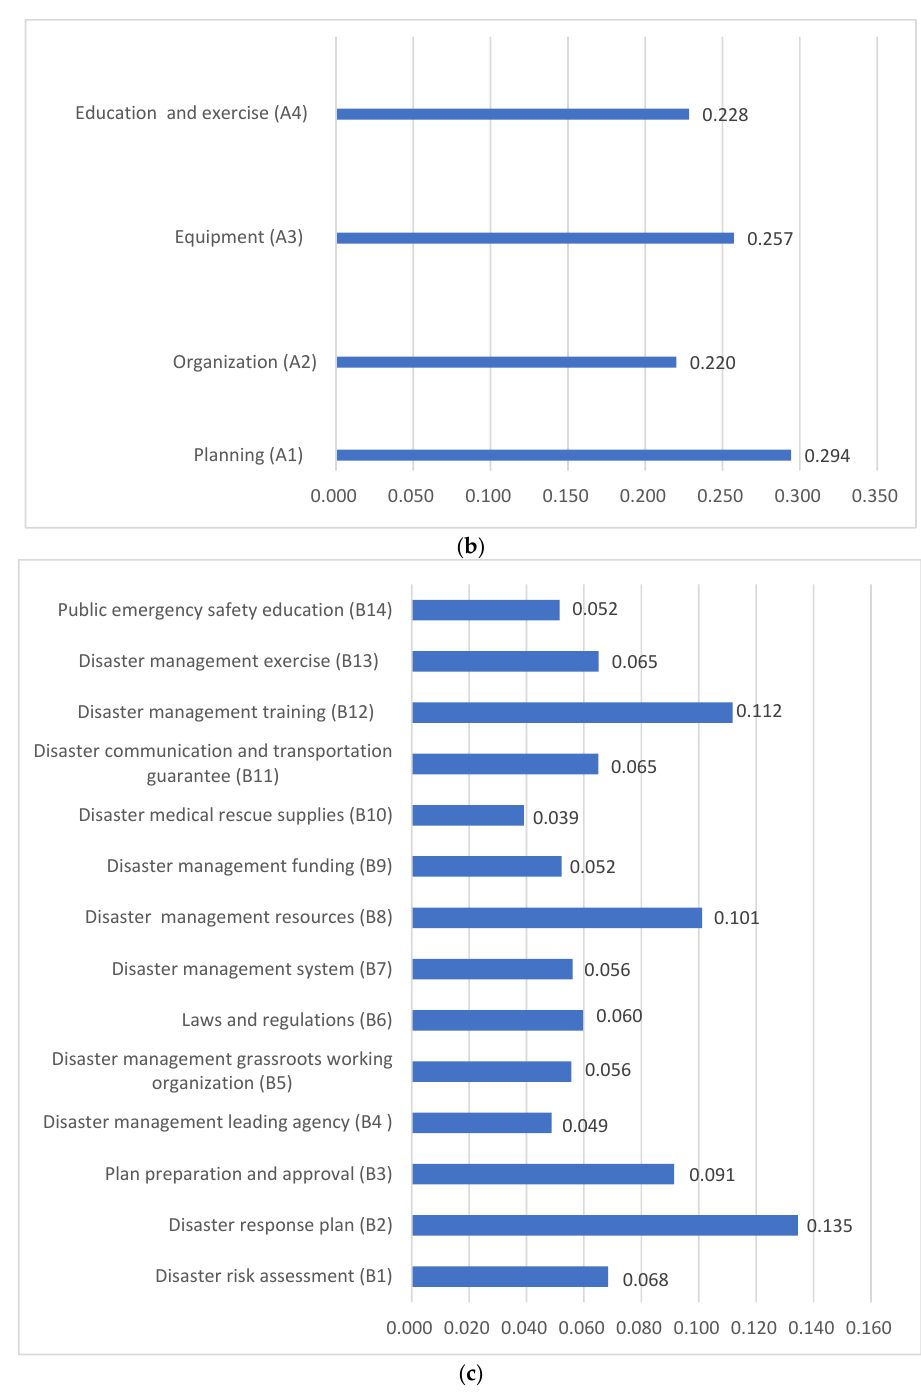
Figure 3. ( a ) Comparisons between different indicators at each level. ( b ) The weight ranking of the second level (A1~A4) to the target level. ( c ) The weight ranking of the third level (B1~B14) to the target level.